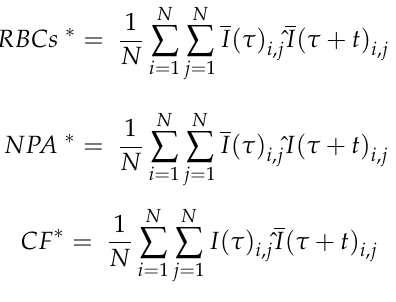
Table 1. The four combinations of the pixel-wise comparison between the image I at reference time τ (denoted as I ( τ ) , and the subsequent images I ( τ + t ) . i , j i , j Inputs Outputs I ( τ ) I ( τ + t ) RBCs i , j NPA i , j CF i , j PA i , j i , j i , j 0 0 1 0 0 0 0 1 0 1 0 0 1 0 0 0 1 0 1 1 0 0 0 1 I ( τ ) denotes the value of the pixel in the i th row, j th column of the reference image i , j and I ( τ + t ) the corresponding pixel of the sequential image at a time τ + t , where τ is i , j the CS time. The outputs RBCs, NPA, CF and PA are new binary data (images) at a given time, after CS, and they have the same size as the compared images, representing specific structural conditions in blood. The information from the Table 1 and the utilization of KM are used to derive indices describing, and quantifying, each of the aforementioned conditions in every image. The indices are developed according to Equations (2)–(5), with N noting the number of pixels of the image (total number of columns N i and total number of rows N j are equal to N, I denoting the complement pixel value of I at that position (logical NOT operation), and with the symbol ˆ denoting the logical AND operation. For each combination and for all images, the total number of ones is divided by the total number of pixels in the image, resulting in the expression of the indices as fractional quantities (denoted with the *